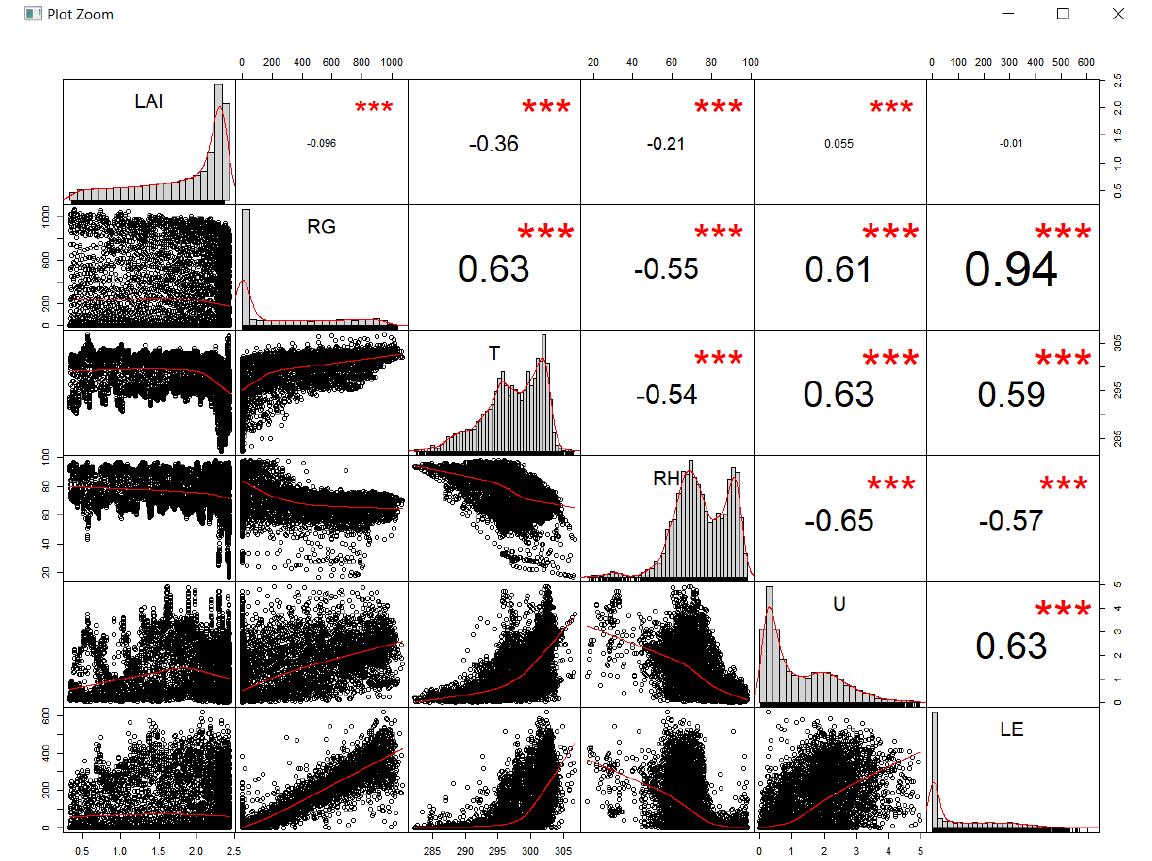
Figure 5. The correlation matrix of half-hourly values of all variables during the 2017 season. The plots on the diagonal show the frequency distribution of each variable. On the top of the diagonal, the values of the correlations are presented with the significance levels as stars (three stars indicate p < 0.001). On the bottom of the diagonal, the bivariate scatter plots with a fitted line (in red) are displayed.